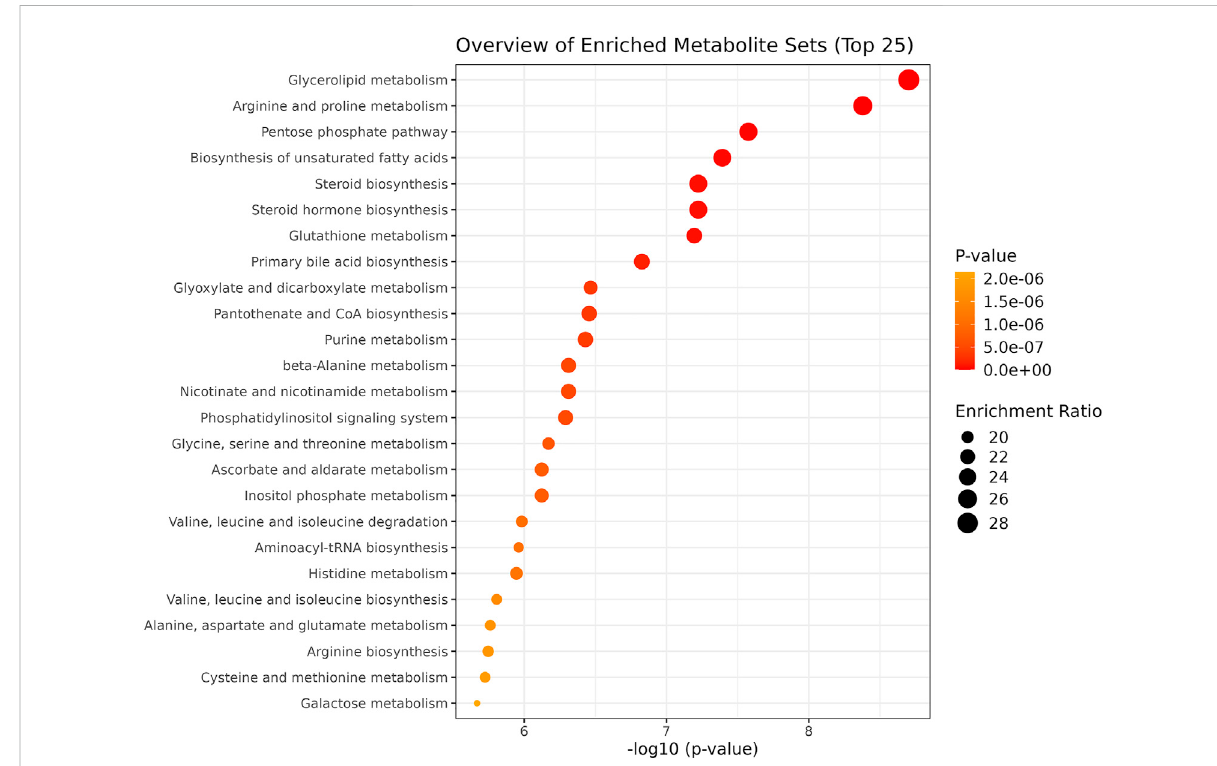
FIGURE 5 Summary plot of the Quantitative Enrichment Analysis (QEA). Enrichment ratio: the dimension of the bubble indicates the enrichment